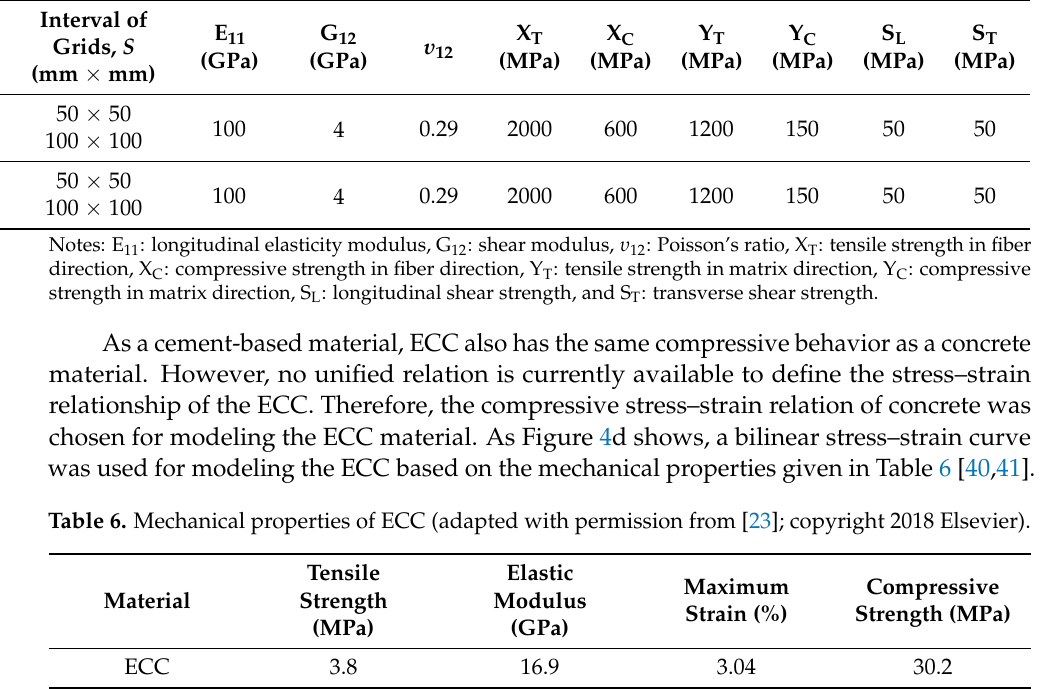
Table 5. Mechanical properties of CFRP girds used in the simulation [23,43].